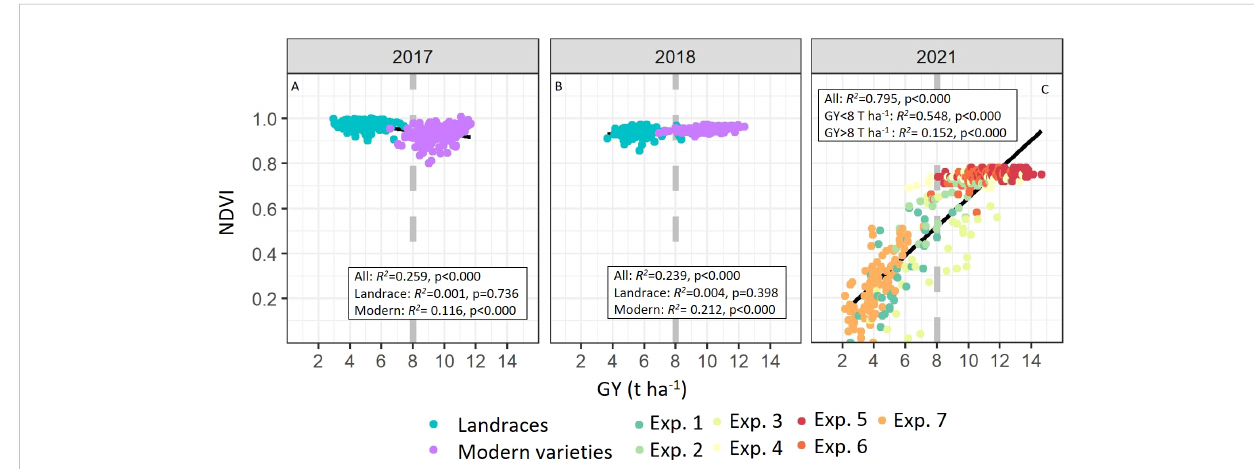
FIGURE 2 Linear relationships between grain yield (GY, t ha-1) with the normalized difference vegetation index (NDVI) measured at anthesis in Case Study 1 ( A , 2017; B , 2018) and 2 ( C , 2021). In case study 1 correlations were calculated separately in modern wheat varieties and landraces. In case study 2, correlations were also calculated separately in plots with yields below and above 8 t ha-1. Coef fi cients of determination (R2) and associated probabilities are shown. Dashed line represents the GY after which NDVI saturates. R2 within experimental conditions from case study 2 were 0.581 for Exp.1, 0.563 for Exp.2, 0.493 for Exp.3, 0.030 for Exp.4, 0.076 for Exp.5, 0.226 for Exp.6 and 0.549 for